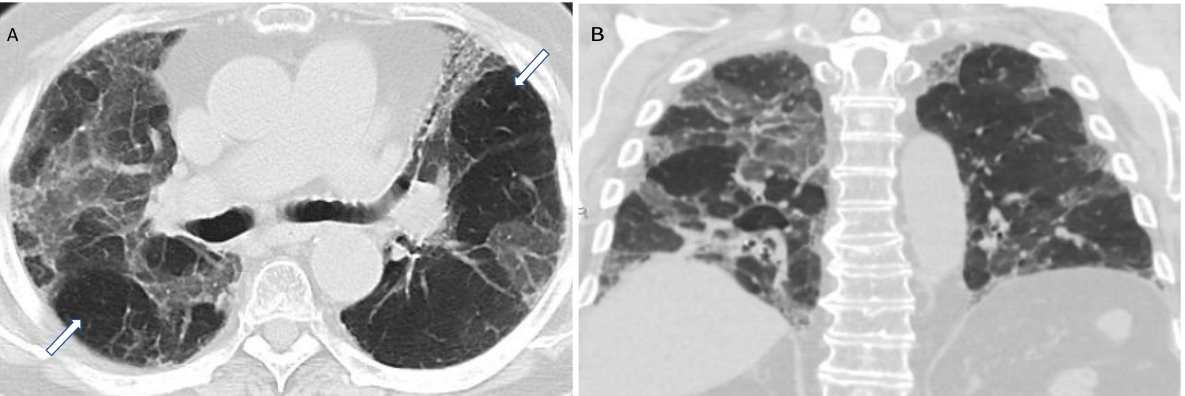
Figure 10. Compatible with fibrotic HP. Axial and coronal expiratory phase CT ( A , B ) shows coarse reticulations and minimal traction bronchiectasis superimposed on extensive upper lung predominant GGOs with peribronchovascular and subpleural distribution. Air trapping (arrows) is evident.